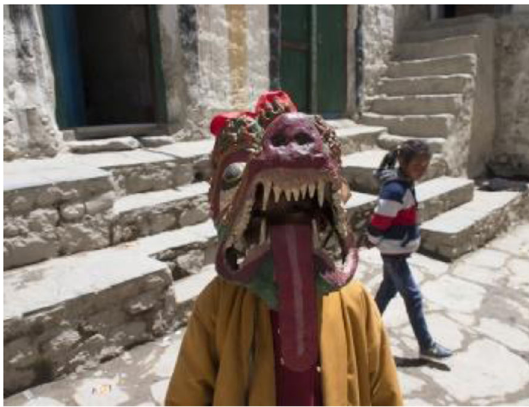
Fig. 16 Sakaluka ritual in Lo- manthang, Photo credit Santosh